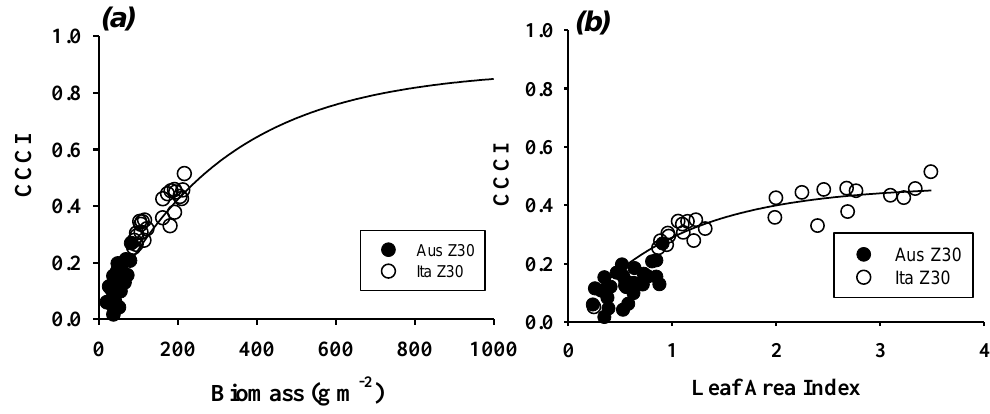
Figure 3. Relationship between the Canopy Chlorophyll Content Index (CCCI) and ( a ) the leaf area index (LAI), and ( b ) biomass for the Australian (closed symbols) and Italian (open symbols) site at